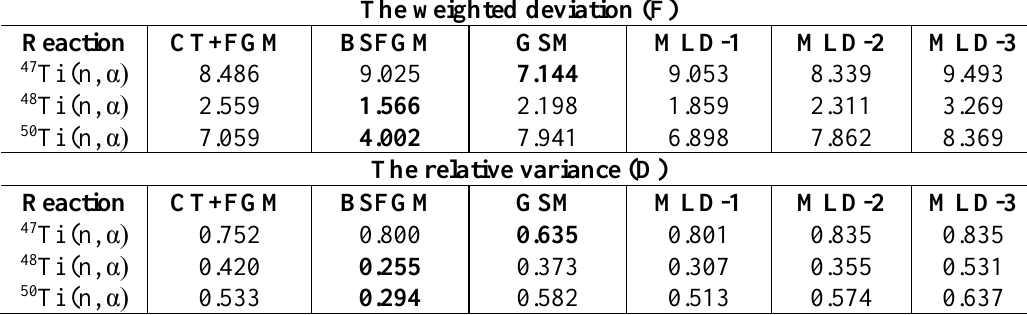
Table 3: The calculated differential cross-sections (dσ/dε and the emission alpha energy (ε